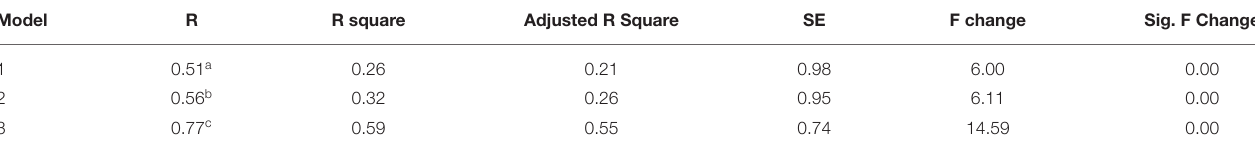
TABLE 1 | Model summary.